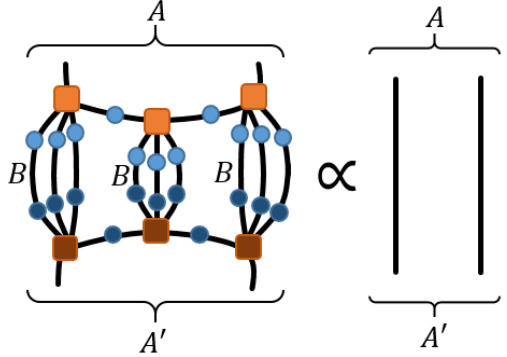
h 1 0 1 i 3 3 3